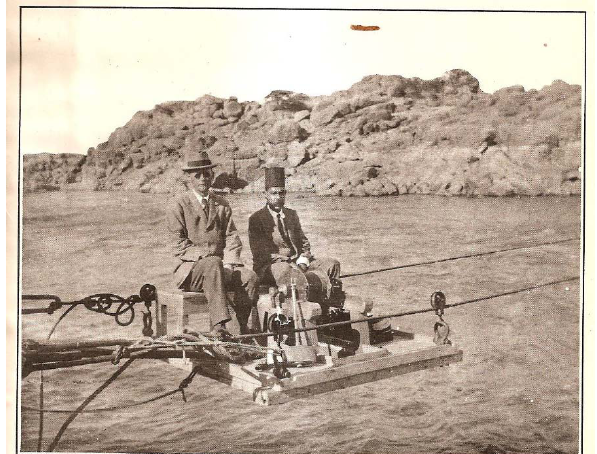
Figure 2. First IAHS President Edward Wade (left) taking flow measurements in the Nile River at Asw¯an in the early